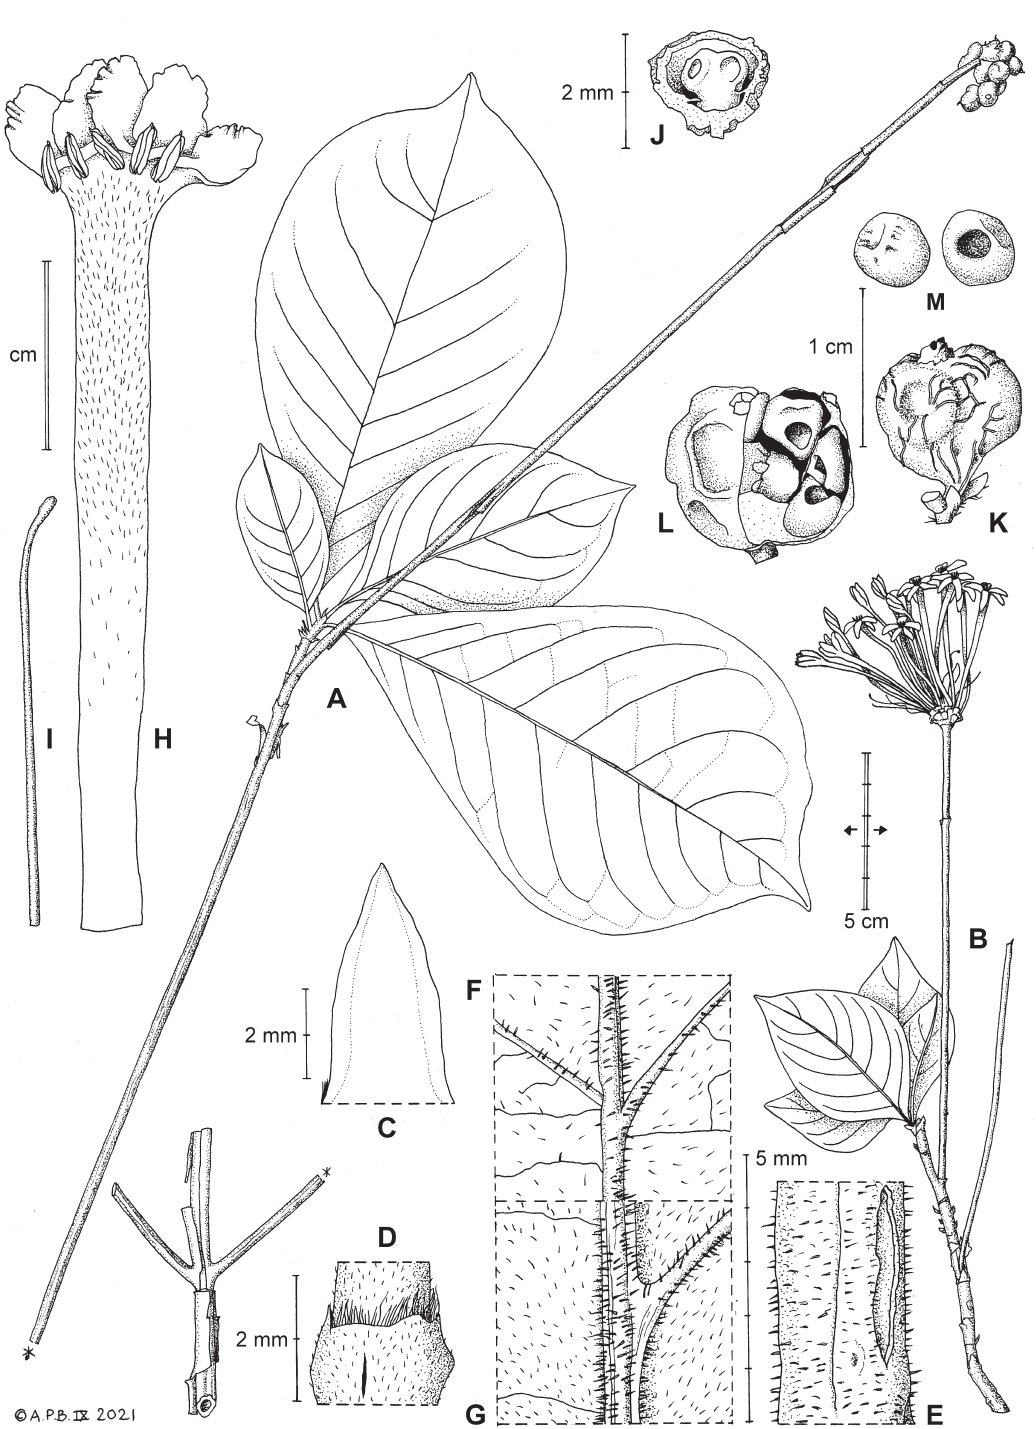
Fig. 1. Cladoceras rovumense I.Darbysh., J.E.Burrows & Q.Luke sp. nov. A . Habit, fruiting shoot. B . Habit, flowering shoot. C . Stipule, external face. D . Hairs revealed beneath fallen stipule. E . Portion of flowering stem showing indumentum. F . Leaf, adaxial indumentum. G . Leaf, abaxial indumentum. H . Dissected corolla with androecium. I . Style and stigma. J . Longitudinal section of ovary. K . Mature fruit. L . Fruit, partially dissected to reveal seeds. M . Seed in two views. A , E–G , K–M from S. Bidgood et al. 1357 ; B , H – I from Q. Luke 13883 ; C – D , J from Q. Luke et al. 10116. Drawn by Andrew